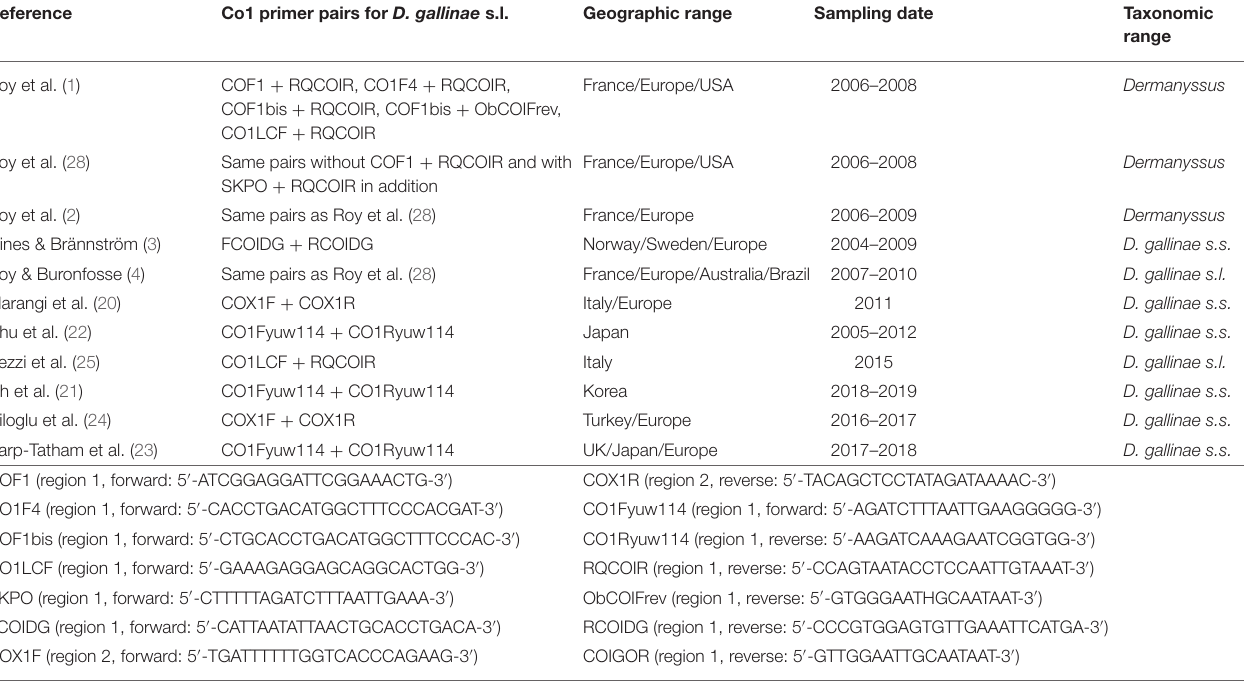
TABLE 1 | Studies selected for integrative